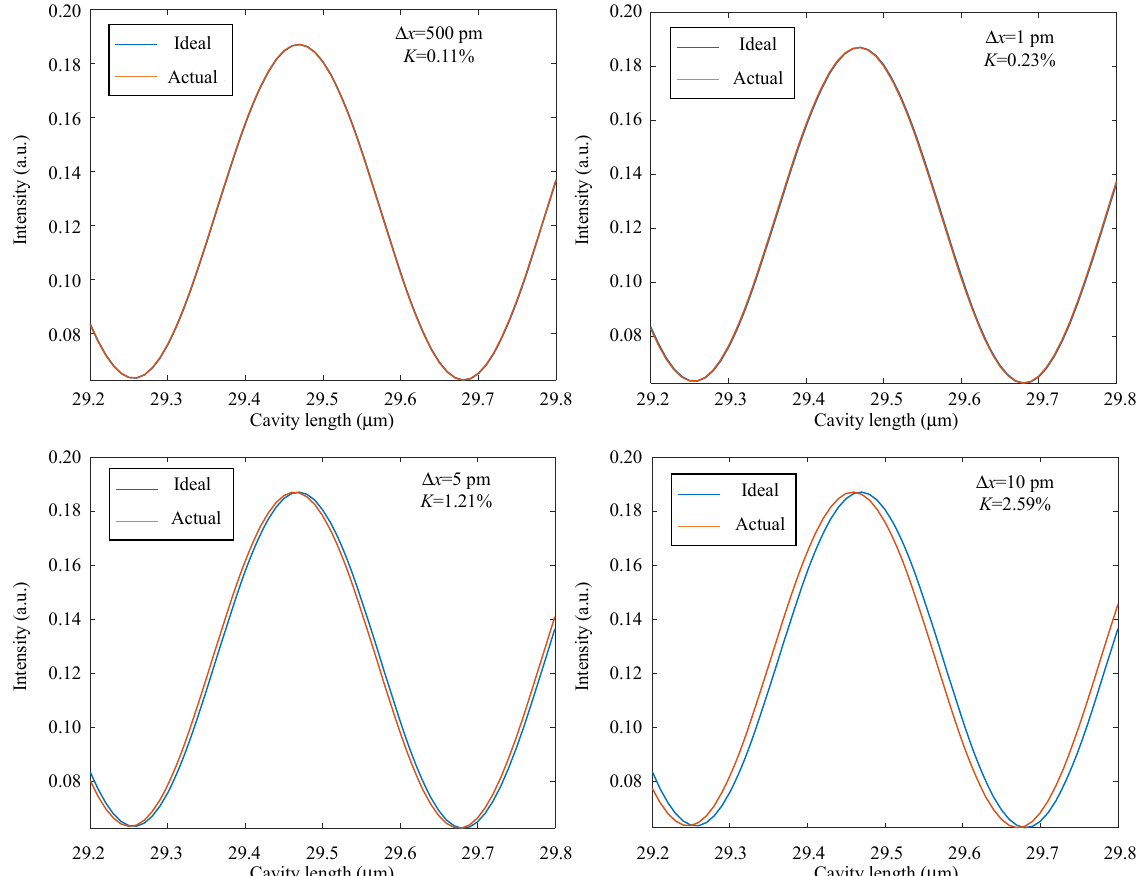
Fig. 10 Comparison figure of signal S 1 between ideal and actual